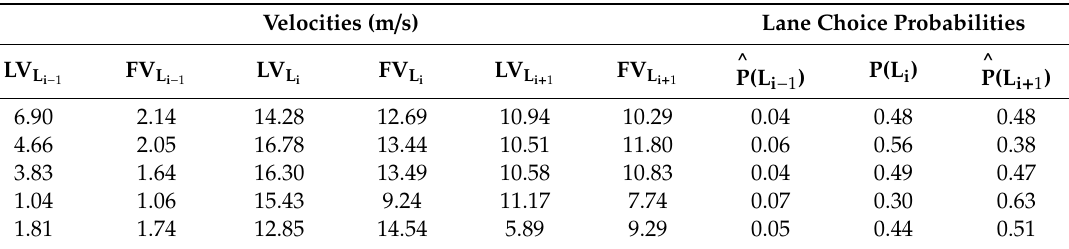
Table 1. Road tra ffi c data 1